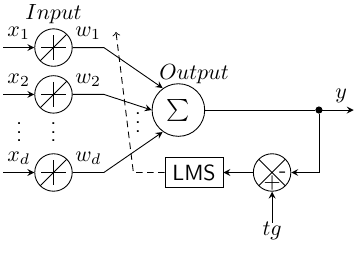
Figure 14. ADALINE